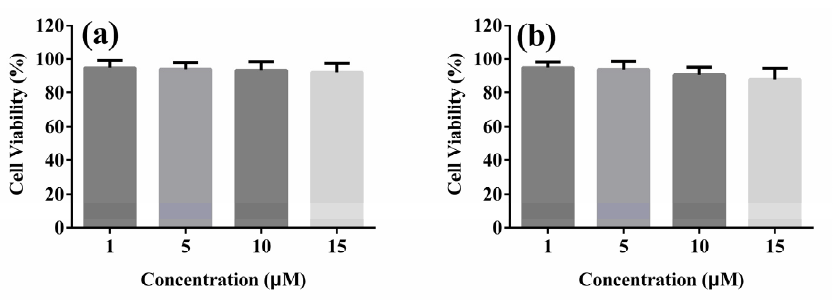
Figure 5. Cell viability of A549 cells treated with different concentrations ( a ) 1 , ( b ) 2 for 24 h.